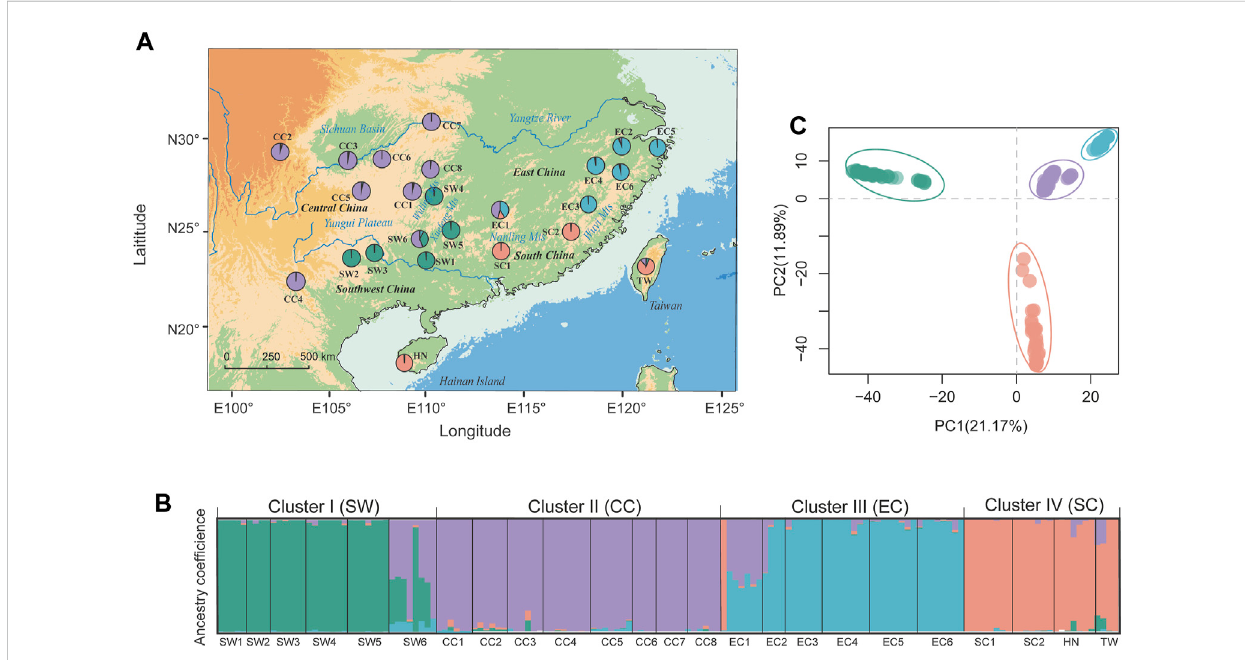
FIGURE 1 Genetic population structure of T. hemsleyanum as revealed by STRUCTURE (left panels) and DAPC analysis (top-right panel). (A) Geographic distribution of 24 populations with pie charts representing the ancestral components inferred by STRUCTURE analysis at K = 4. (B) Histogram of population assignment using STRUCTURE analysis with K = 4. The colored segment in each bar represents the individual ancestry coef fi cient of inferred clusters (or “ gene pool ” ). (C) Population assignment results inferred from DAPC (using the R package